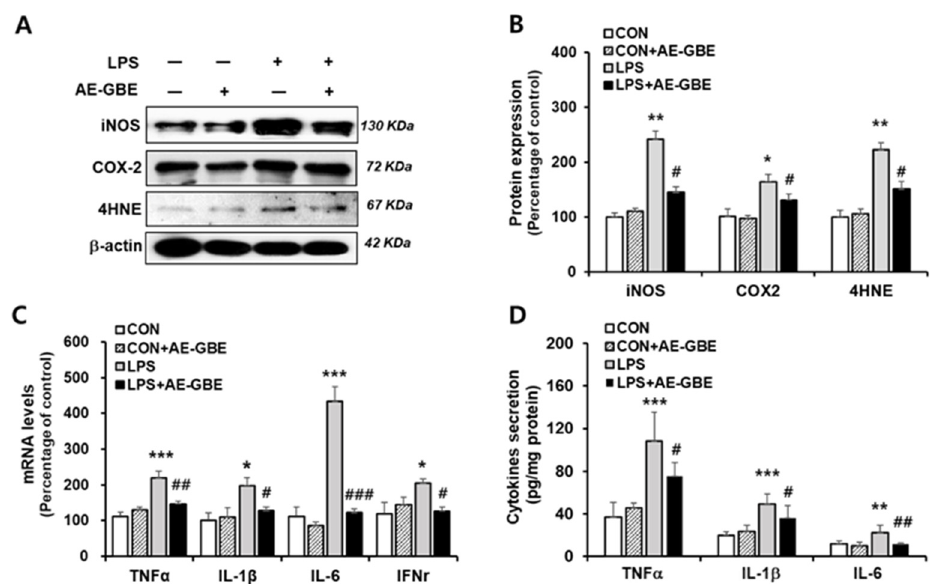
Figure 2. Effects of AE-GBE on inflammatory mediators in LPS-induced Caco-2 cells. iNOS, COX-2 and 4HNE protein expressions in Caco-2 cells were determined via ( A ) Western blotting and ( B ) quantified. ( C ) TNF α , IL-1 β , IL-6, and IFN γ expressions were analysed using qRT-PCR. ( D ) TNF α , IL-1 β , and IL-6 proteins in culture medium were detected by ELISA assay. Data represent mean ± SD ( n = 3–5). *: p < 0.05, **: p < 0.01, and ***: p < 0.001versus the CON group; #: p < 0.05, ##: p < 0.01 and ###: p < 0.001 versus the LPS alone group.